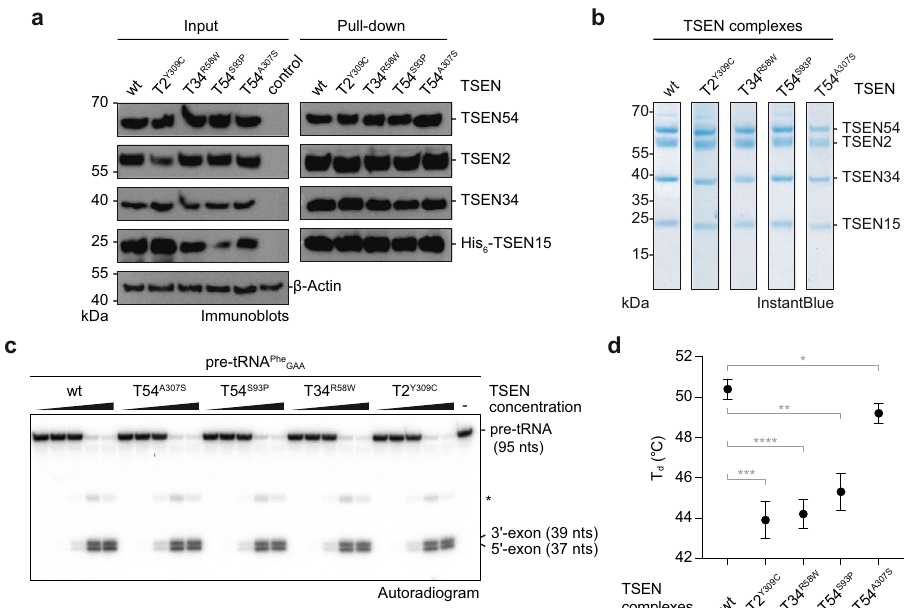
Fig. 4 PCH mutations affect thermal stability but not activity of recombinant TSEN. a Immunoblot analysis of a pull-down assay with wt and mutant TSEN complexes co-expressed in HEK293 cells. Size markers and protein identities are indicated. b SDS-PAGE of SEC peak fractions of puri fi ed recombinant wt and mutant heterotetrameric TSEN complexes. c Pre-tRNA endonuclease assay of radioactively labeled S.c . pre-tRNA Phe GAA with increasing amounts of recombinant wt or mutant TSEN complexes revealed by phosphorimaging. d Thermal stability of recombinant wt and mutant TSEN complexes assessed by DSF. Shown are means of the denaturation temperature (T d ) of each complex with fi t errors derived from Boltzmann sigmoids. Fit errors were derived from means of technical triplicates and are representative of biological duplicates (* P = 0.0424, ** P = 0.0010, *** P = 0.0004, **** P = 0.0002; unpaired two-tailed Student ’ s t -test). Source data for a , b , and c , are provided as Source Data fi